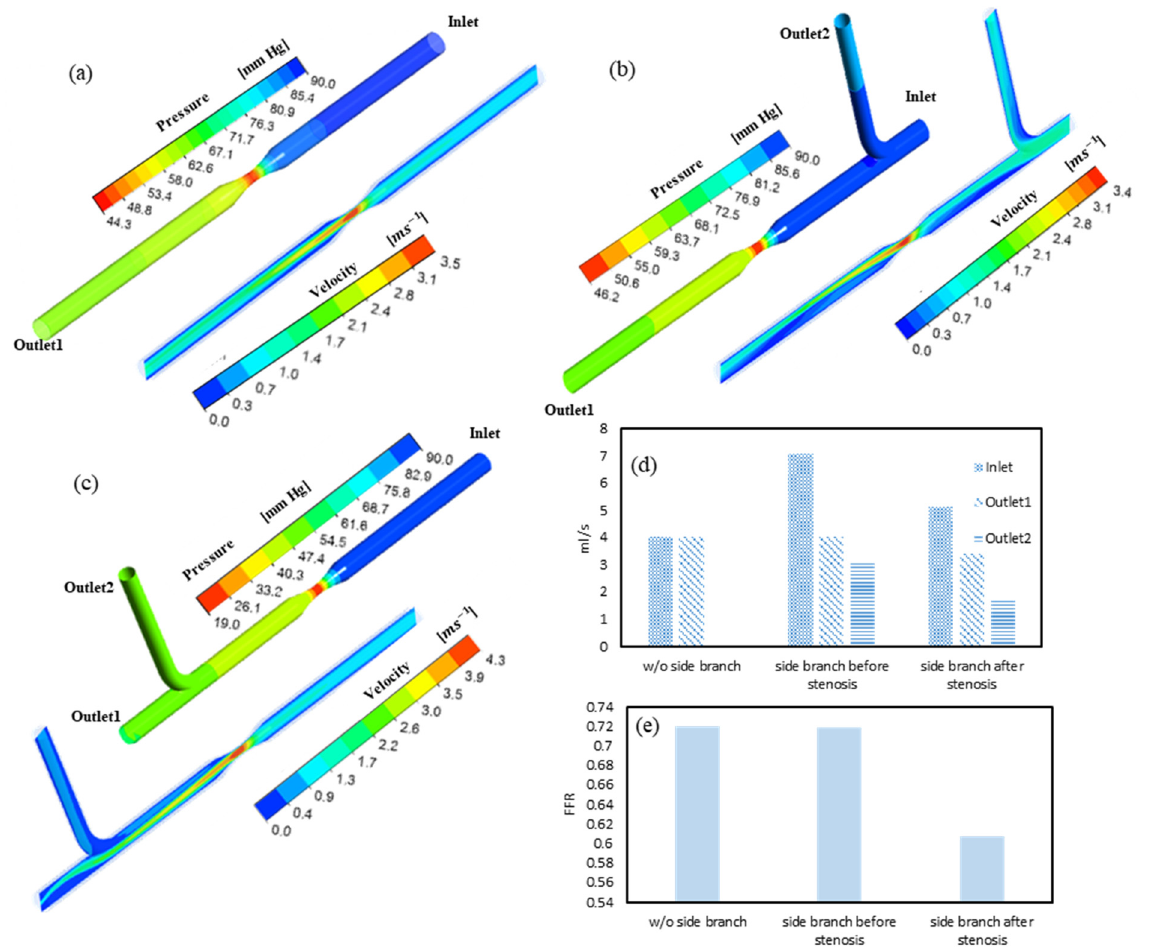
Figure 4. CFD-derived pressure and velocity distributions in an idealized artery model: ( a ) model 1: without side branch; ( b ) model 2: with side branch located at the upstream; ( c ) model 3: with a side branch located at the downstream. Comparison of ( d ) flowrate into side branches and ( e ) CFD-derived FFR between the three models.